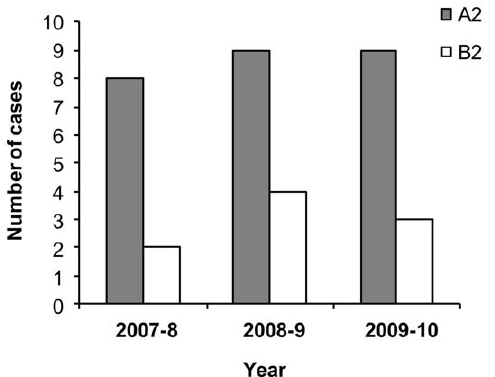
Figure 5. Identification of new hMPV subtype. The figure shoe a phylogenetic tree that was constructed based on the nucleotide sequences (111 bp) of the Fusion gene (F protein).